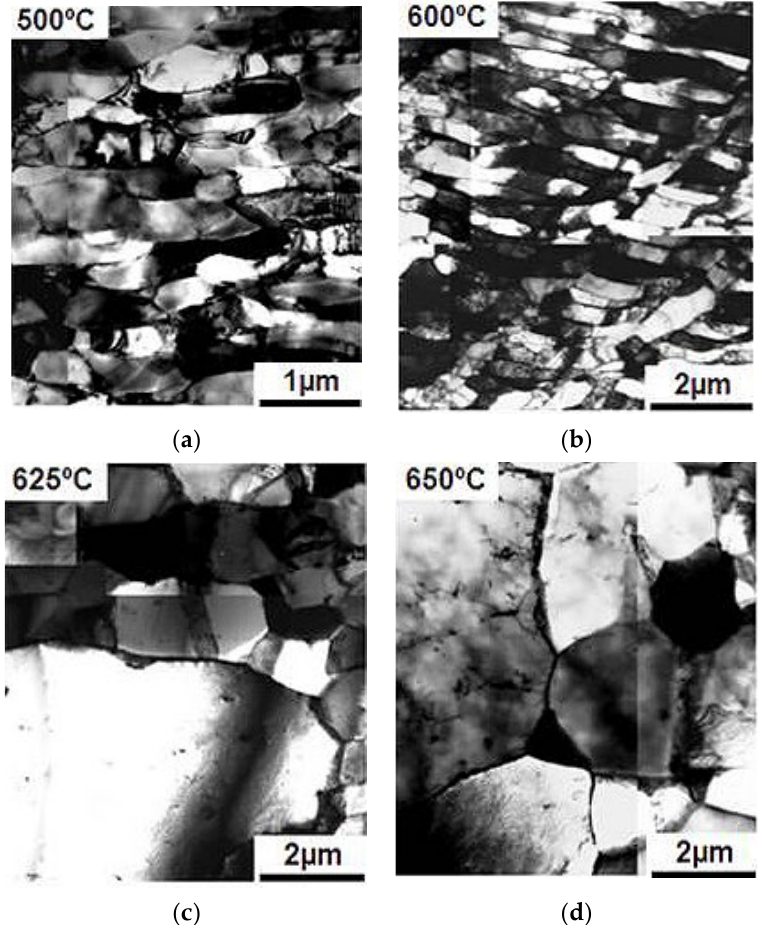
Figure 7. Microstructure of steel deformed with the HPT method at cryogenic temperature during heating: ( a ) 500 ◦ C; ( b ) 600 ◦ C; ( c ) 625 ◦ C; ( d ) 650 ◦